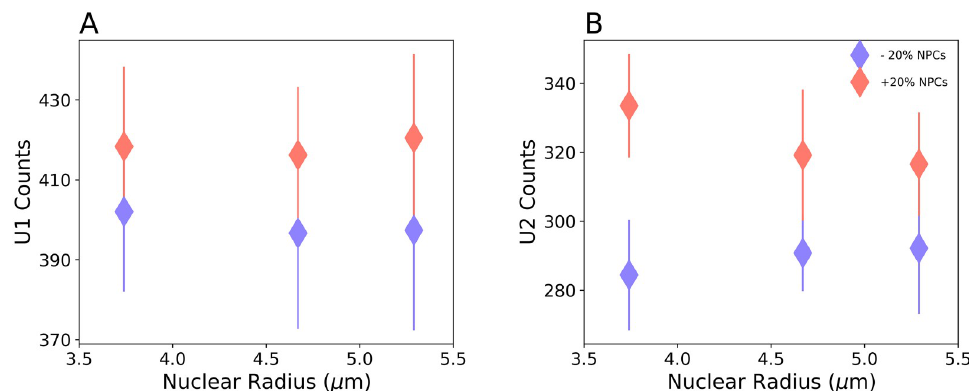
Fig 3. Spliceosomal particle formation depends on NPC count. Increase (pink) or decrease (blue) in the number NPCs by 20% results in a corresponding change in the number of U1 (A) and U2 (B) particles formed. The effect is consistent for different nuclear sizes. P-values for U1 results are: 1.8 × 10 − 2 (3.7 μ m), 6.8 × 10 − 3 (4.7 μ m), 4 × 10 − 3 (5.3 μ m); and for U2 results are: 3.9 × 10 − 12 (3.7 μ m), 6.4 × 10 − 6 (4.7 μ m), 8.5 × 10 − 5 (5.3 μ m). Error bars represent the standard deviations. For each condition, 20 simulation replicates for duration of 30 seconds were